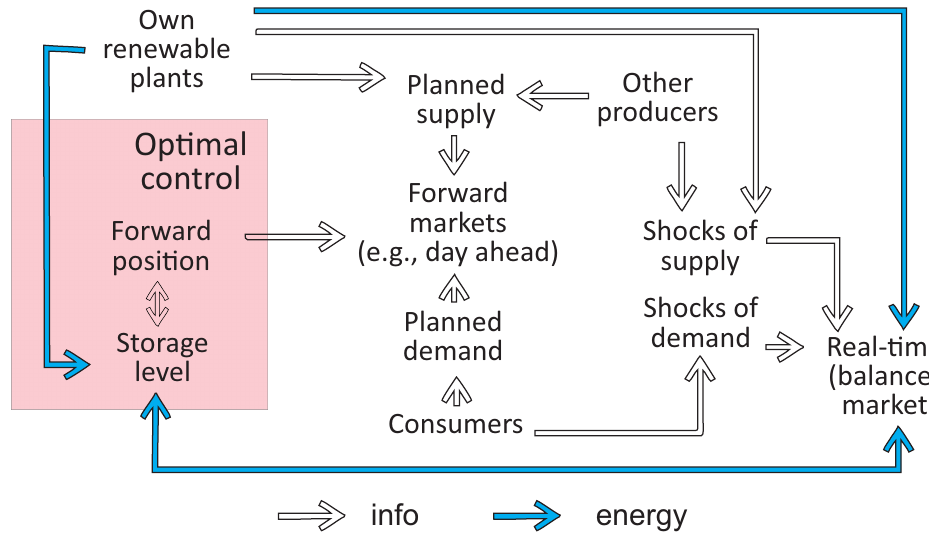
Figure 2. Energy dispatch in the presence of renewable energy and battery storage. White arrows represent the flows of information, whereas filled arrows stand for flows of energy. The matching of planned demand with energy supply on the forward market is not